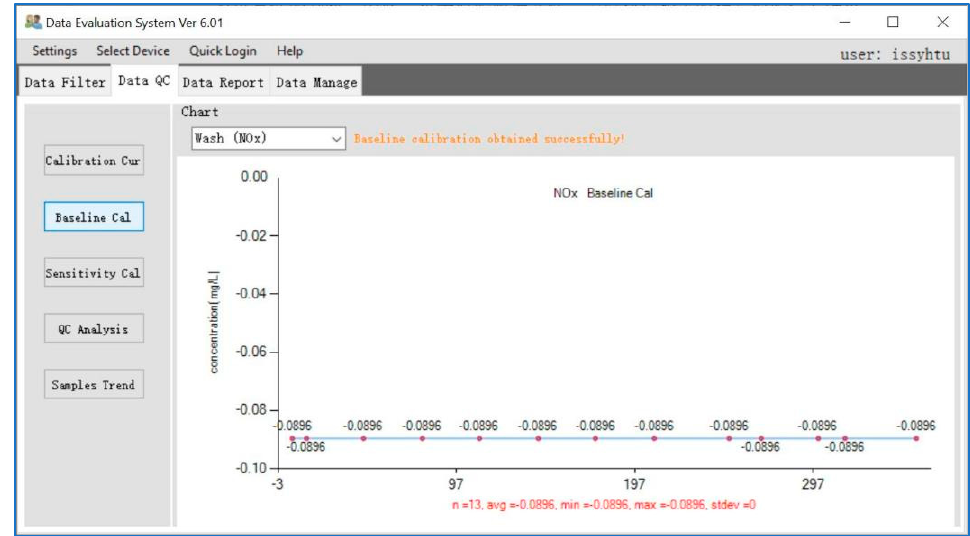
Figure 12. Baseline calibration of the sample data.